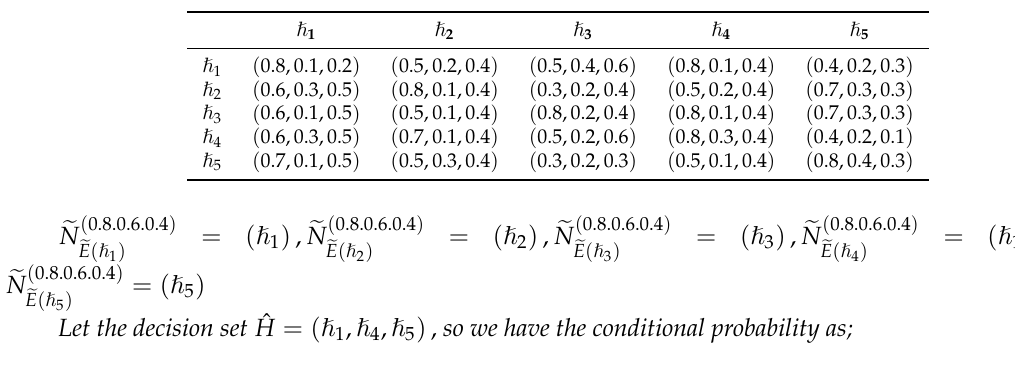
Table 2. FOF β —neighborhood (cid:101) N